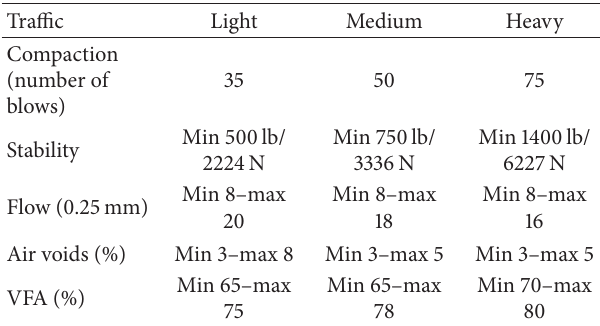
Table 4: SMA specifications.